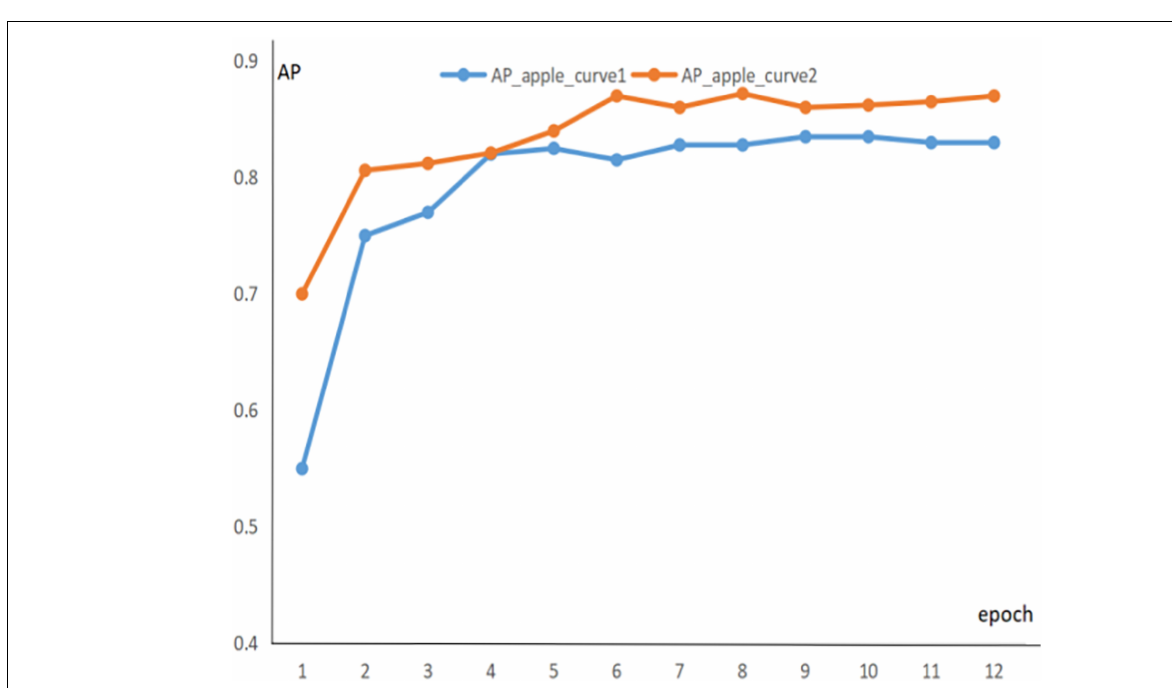
training the green fruit dataset, allowing for a faster fit. The 1600 images containing apples are extracted from the common COCO dataset, these images are applied for pre-training experiments, and the information of the pre-trained parameters is